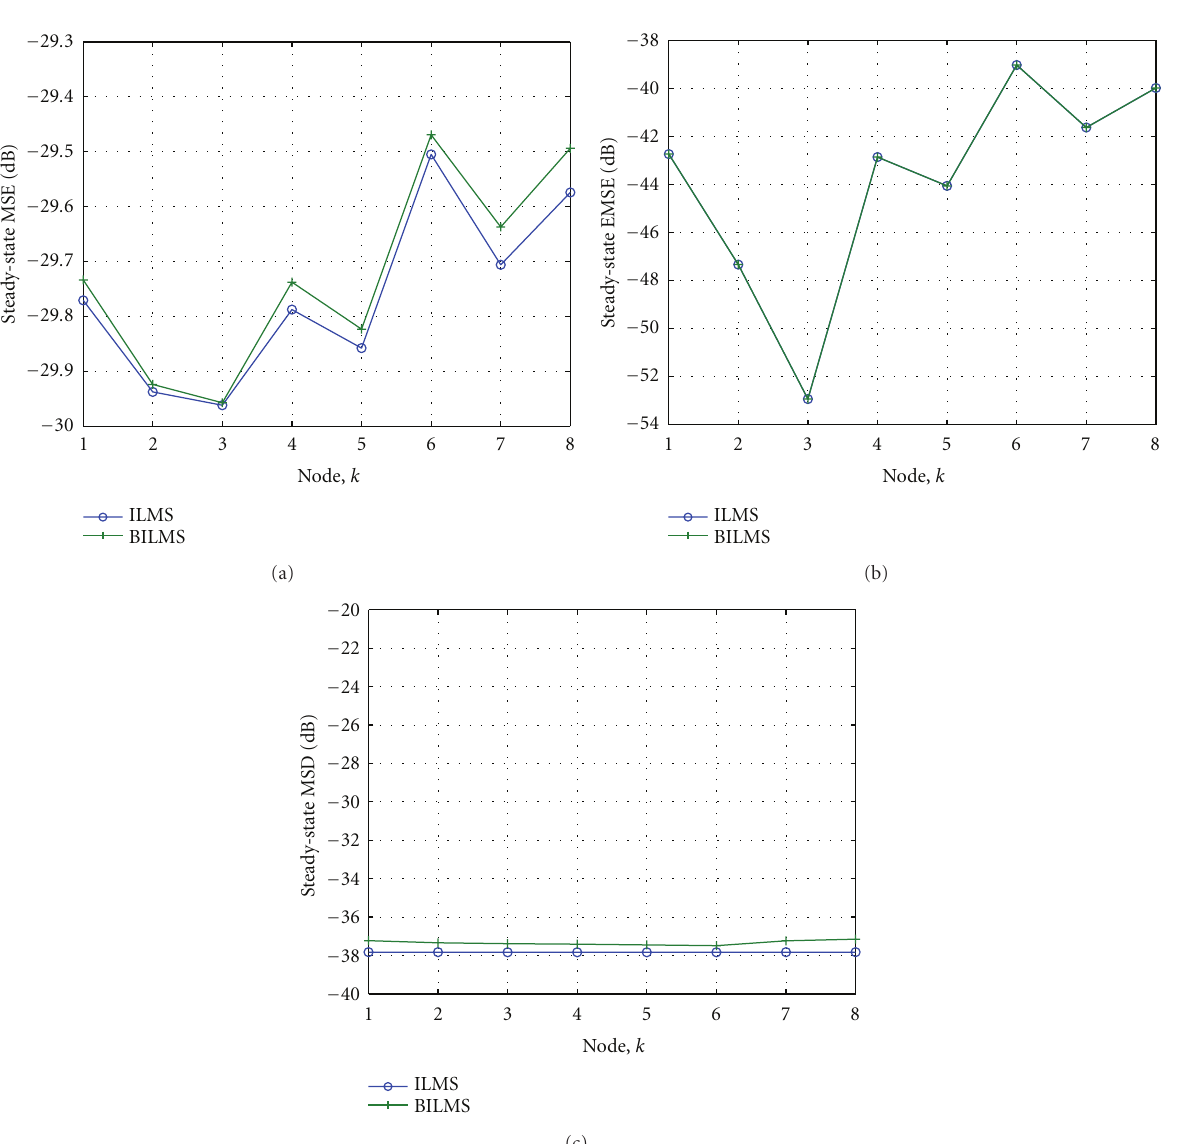
Figure 9: Network nodal performance. (a) Mean-square error (MSE) versus node. (b) excess mean-square error (EMSE) versus node. (c) Mean-square deviation (MSD) versus